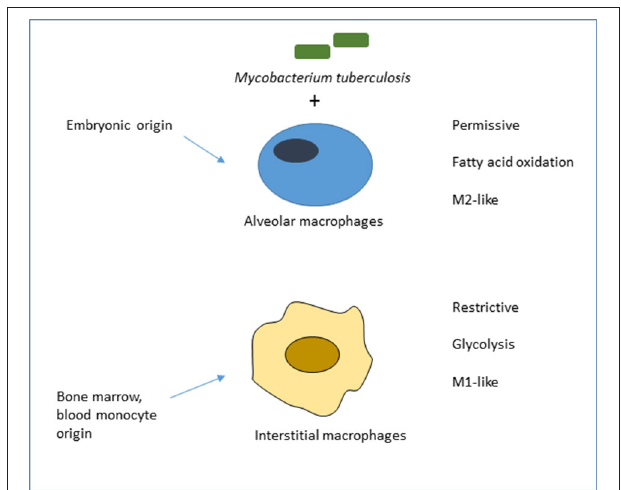
FIGURE 1 | Ontogeny of mouse lung macrophages shapes the outcome of initial MTB infection in vivo . Adapted from Huang et al. (2018), who compared the role of alveolar macrophages (AM), of embryonic origin, with mainly monocytic, bone marrow-derived interstitial macrophages (IM) in acute infection of mice by fluorescent MTB reporter strains. Bacilli in AM, deriving energy from fatty acid oxidation, grew more readily than IM, which were actively glycolytic, more restrictive and expressed M1-like rather than M2-like markers of macrophage activation. The authors favored a model of pre-programming, linked to ontogeny, rather than adaptation to the distinct local microenvironment. There is suggestive, but no direct, evidence in humans that alveolar and other tissue-resident macrophages are of embryonic origin. This conclusion is based on transplantation studies of donor and recipient macrophages in skin (Bigley et al., 2011) and small intestine (Bujko et al., 2018 ), and evidence of local turnover in lung rather than bone marrow origin. It is not known which plasma membrane receptors mediate uptake of MTB in this in vivo model. Alveolar macrophages in the mouse express low levels of F4/80 and of CD11b, and high levels of several plasma membrane receptors: lectins such as the mannose receptor (CD206), and the Scavenger Receptor AI/II and MARCO, which are involved in the uptake of inhaled particles such as MTB (Gordon et al., 2014a). Other widely studied lectins expressed by lung macrophages include the FcRgamma-coupled receptors Dectin-2, Mincle and MCL, as well as Dectin-1, Mannose Receptor and DC-SIGN ( Marakalala and Ndlovu,